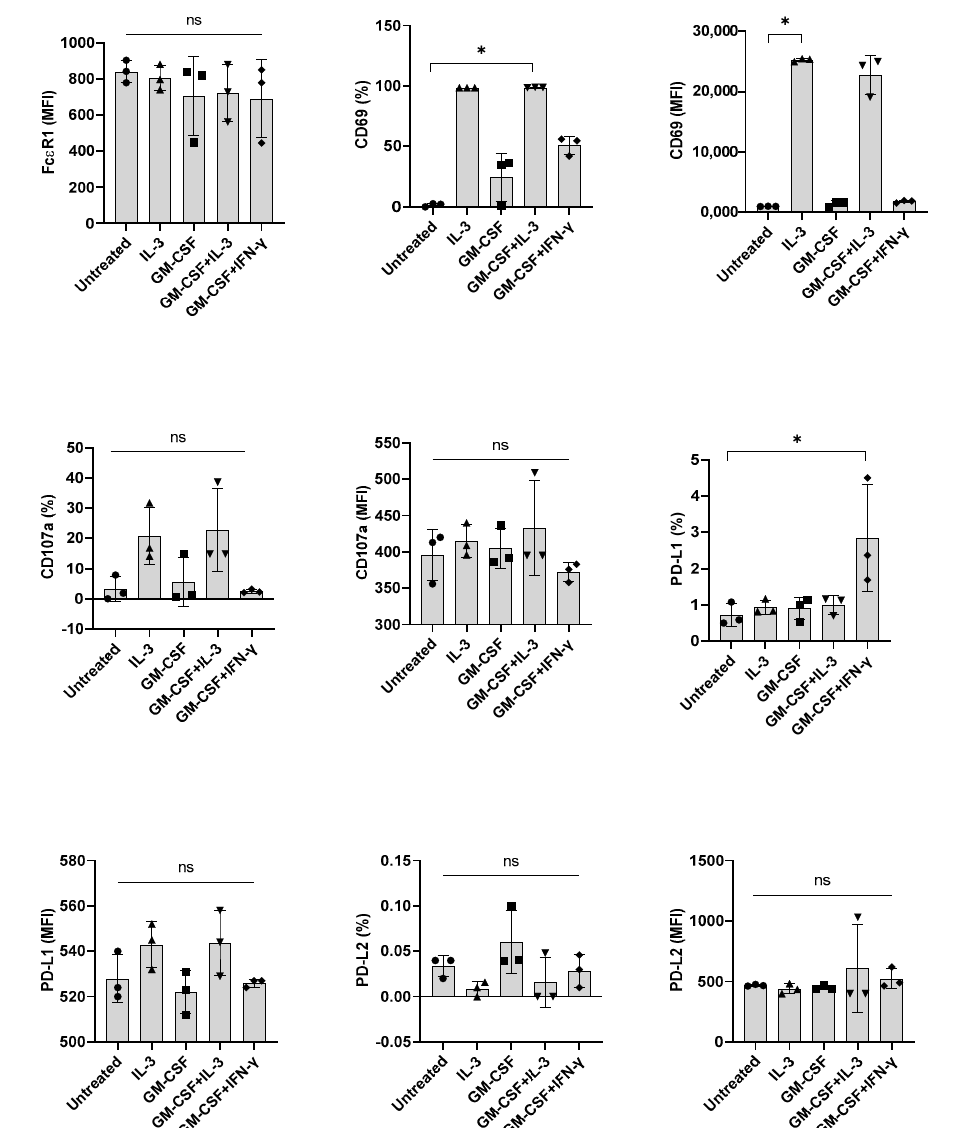
Figure 4. The effect of GM-CSF on the expression of PD-L1, induced by IFN- γ in primary human basophils. Basophils (0.1 × 10 6 cells/200 µ L/96-well plate) isolated from PBMCs of healthy donors were cultured with either IL-3, GM-CSF (5 ng/mL), GM-CSF + IL-3 or GM-CSF + IFN- γ . Basophil phenotype was evaluated by flow cytometry after 24 h. Expression of Fc ε RI, CD69, CD107a, PD-L1, and PD-L2 on the basophils (% positive cells and median fluorescence intensities (MFI), mean ± SD; n = 3 independent donors from three independent experiments) was presented. ns, not significant, * p < 0.05, one-way ANOVA Friedman test with Dunn’s multiple comparisons post-test.